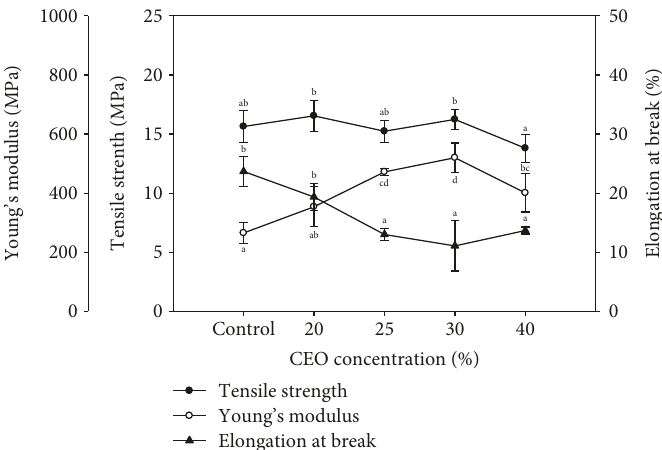
Figure 2: Tensile strength, elongation at break, and Young ’ s modulus of pure alginate fi lm and alginate fi lms incorporating various CEO-NE concentrations. Di ff erentletters indicatea signi fi cant di ff erence at p < 0 05 bythe ANOVAtest. Errorbars representstandard deviation( n = 3